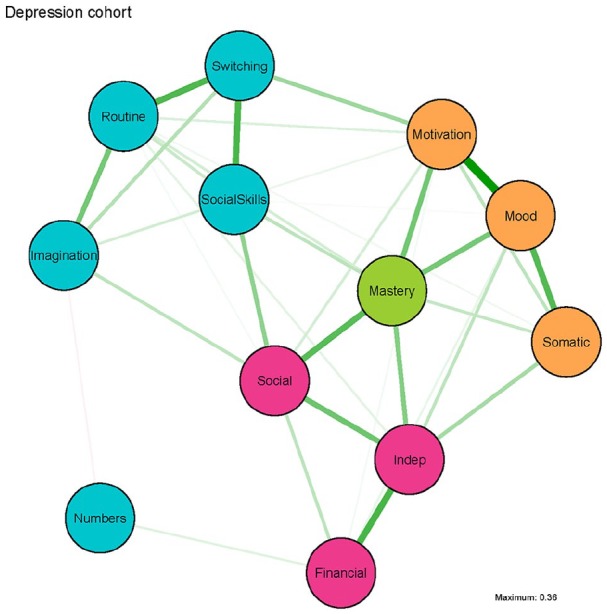
Network of autistic traits, depression symptoms, worry symptoms and mastery in Study 1: the depression cohort.Green lines represent positive associations and red lines represent negative associations. A thicker and more saturated edge represents a stronger connection, and nodes that are strongly interconnected are depicted closer together. Autistic traits measured by the AQ-28: Social Skills = poor social skills; Routine = a desire for routine; Switching = difficulty in switching between tasks; Imagination = impaired imagination; Numbers = a fascination for numbers and patterns. Depression symptoms measured by the IDS-SR: Mood; Motivation; Somatic. Worries measured by the Worry Scale-R: Social = worries about social conditions; Financial = financial worries; Indep = worries about loss of independence. Mastery measured by the Pearlin Mastery Scale: Mastery.